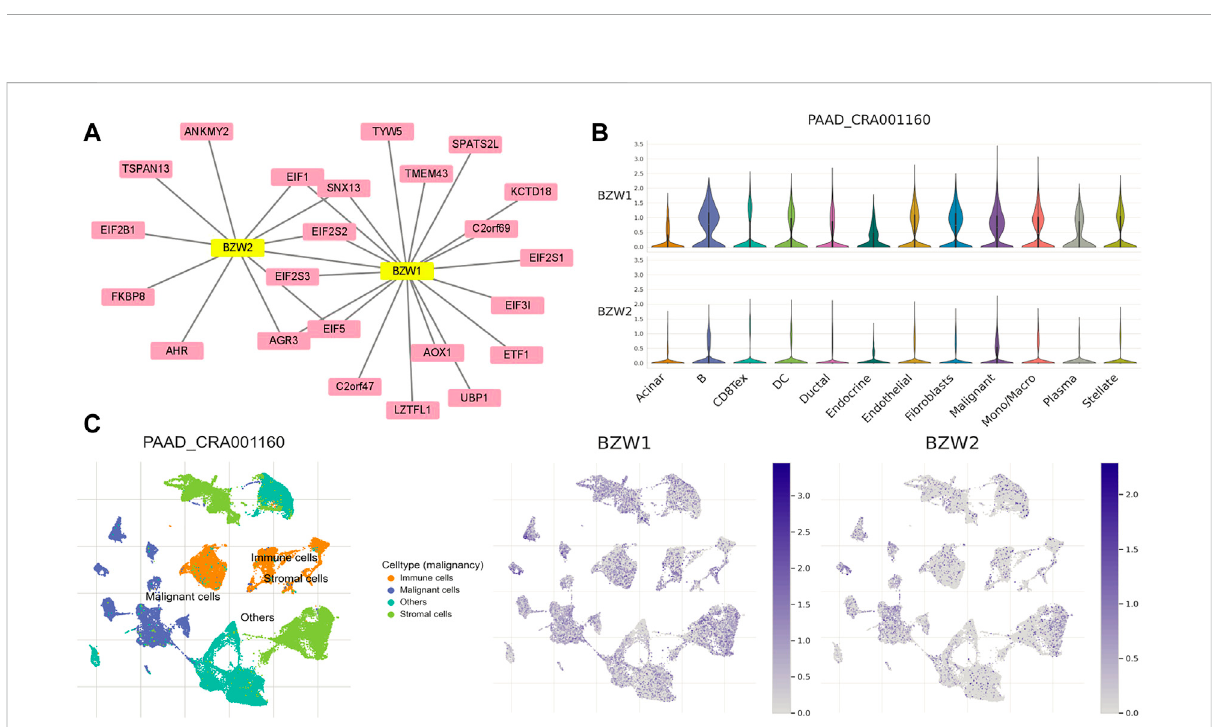
FIGURE 8 (A) PPI network ofBZW1- and BZW2-corrected genesbased on Cytoscape. (B) Violin plots indicated the expression of BZW1 and BZW2among different cell types in the PAAD_CRA001160 cohort. (C) T-distributed stochastic neighbor embedding plots showed the expression of BZW1 and BZW2 in different cell